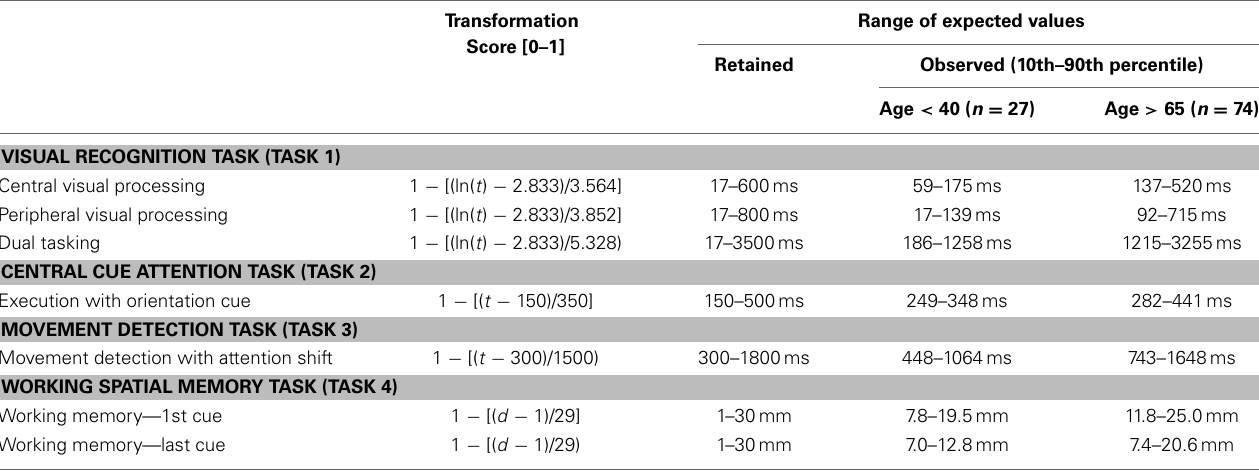
Table 1 | Retained MedDrive outcomes from derivation